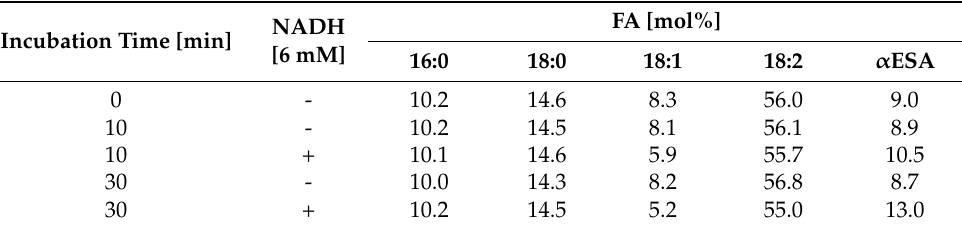
Table 1. Changes in the fatty acid composition of complex lipids of the microsomal fraction of developing seeds of Momordica charantia during incubation with and without NADH. Mean values from duplicates are presented. In the assays microsomal fractions (aliquots contained 112 nmol microsomal PC; about 612 nmol of FA of all acyl-lipids) were incubated with and without the addition of NADH. No other exogenous substrates were added to the assays.